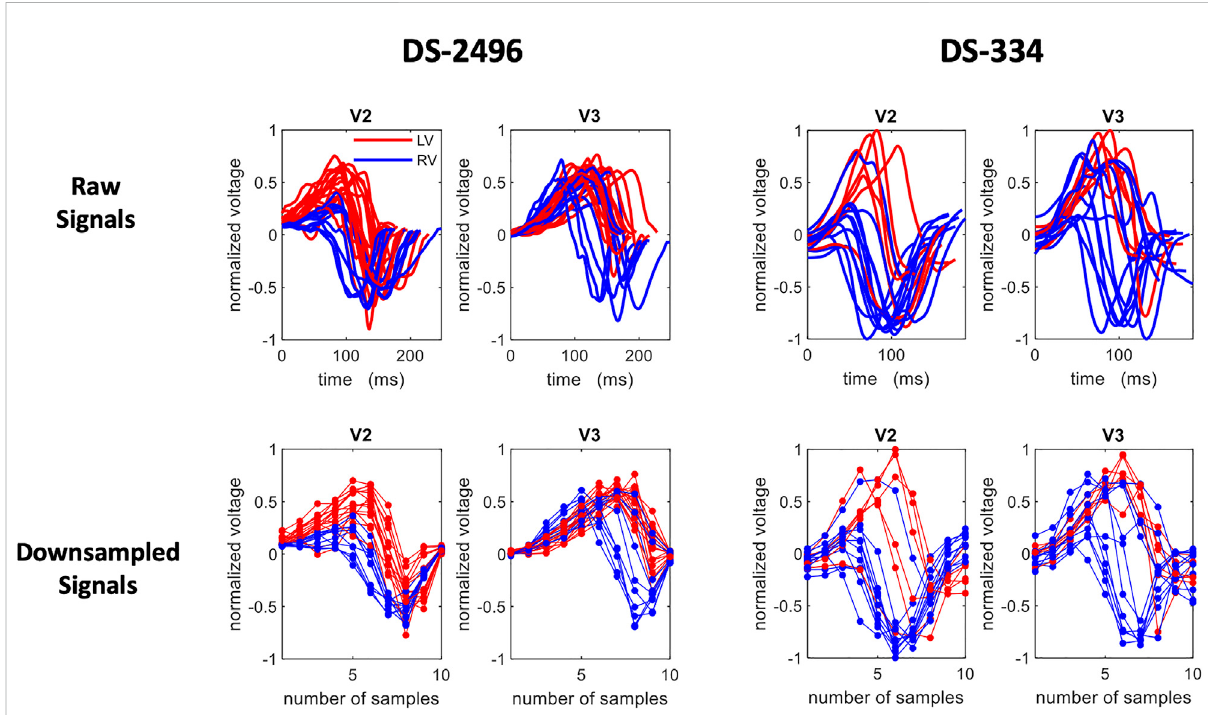
FIGURE 2 A set of selected ECG traces from the simulated (DS-2496) and the DS-334 datasets. The extracted QRS of the V2 and V3 precordial leads are shown in the top row and their corresponding down-sampled traces (10 samples) in the bottom row. Right Ventricle (RV) signals are plotted in blue, whereas left ventricle (LV) signals are in